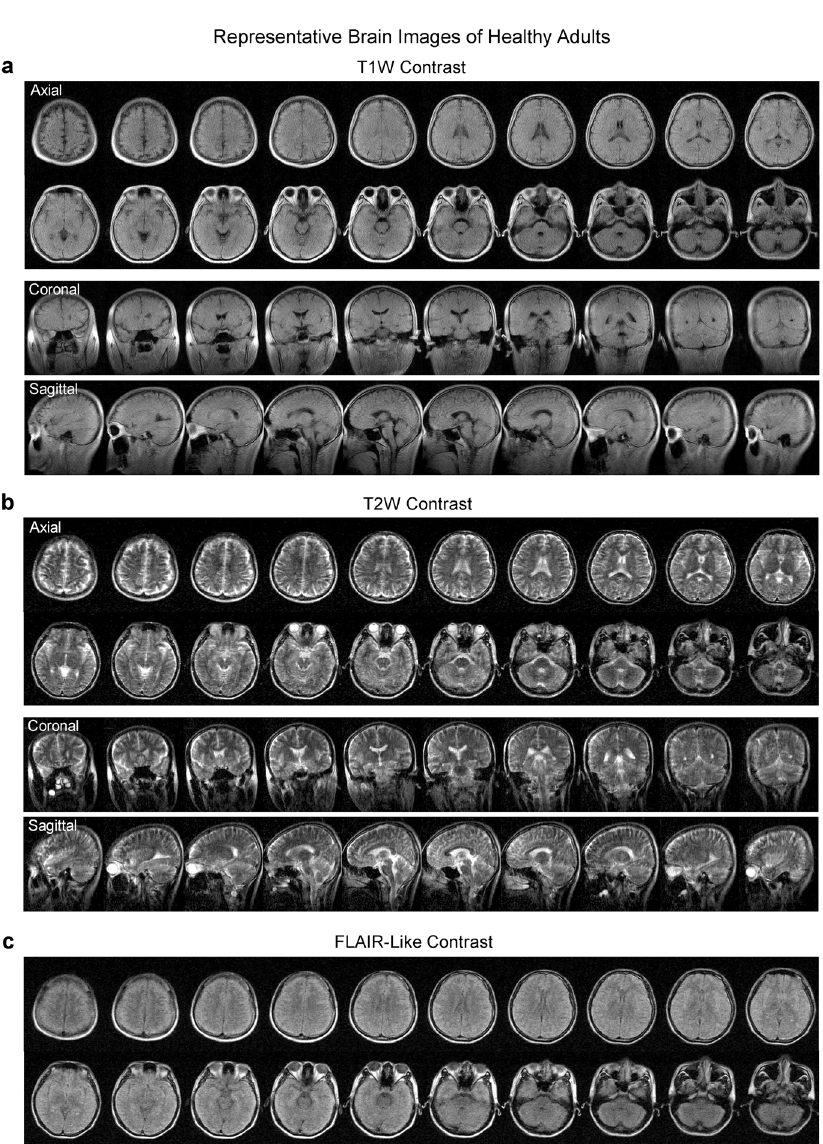
Fig. 4 Typical brain images from healthy adults produced by the low-cost and shielding-free 0.055 T MRI scanner. Whole-brain axial, coronal and sagittal sections of the brain were acquired at two common contrasts, namely a T1-weighted (T1W) images using the 3D gradient-echo sequence and b T2W using 3D fast spin echo sequence. c Whole-brain axial sections acquired with fl uid-attenuated inversion recovery (FLAIR) like contrast using the 3D FSE sequence with short TR. Scan times are 5.5 mins, 7.5 mins and 7.5 mins for T1W, T2W and FLAIR protocols, respectively. All images are displayed at a spatial resolution of 1 × 1 × 5 mm 3 , while the acquisition resolution is approximately 2 × 2 × 10 mm 3 . The axial (23 yrs. old; male) and coronal/sagittal (23 yrs. old; male) images shown here were acquired from two healthy adults,